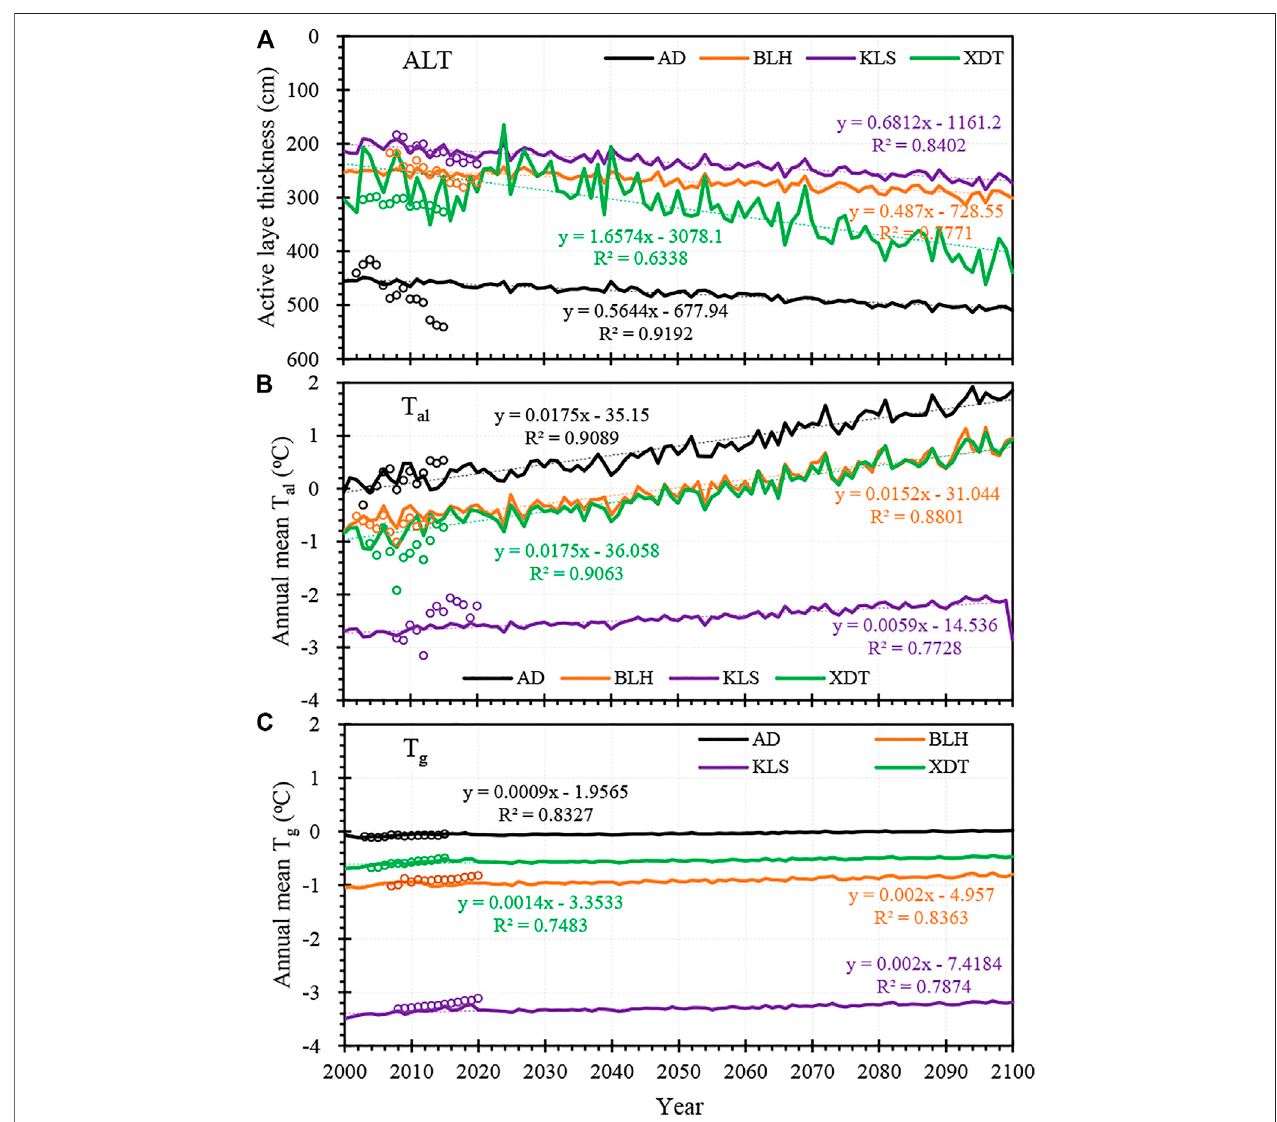
FIGURE 10 | Simulated possible changes of ALT (A) , annual mean T al (B) , and T g (C) at the four sites over the next 100 years under the SSP585 climate change situation. Circles represent the measured values before 2020.